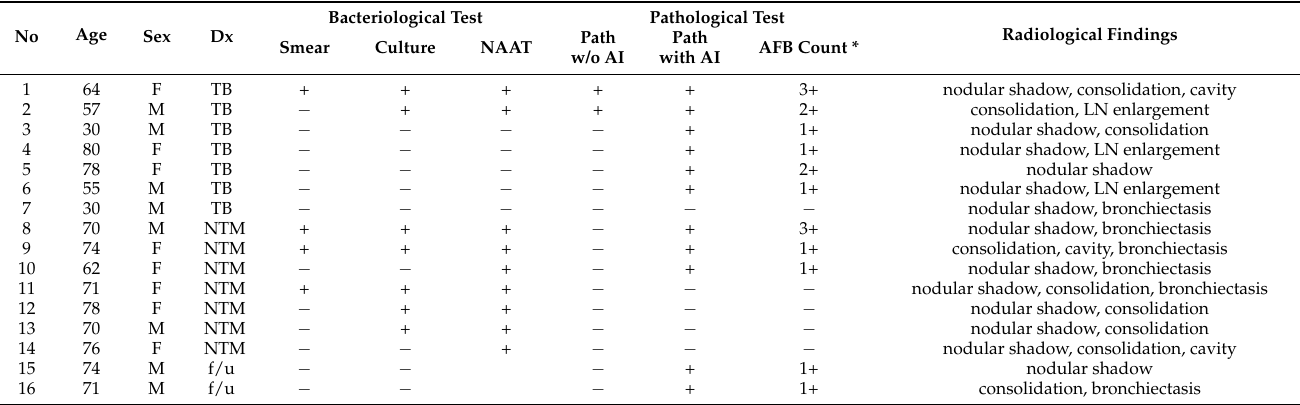
Table 4. Results of radiological, bacteriological, and pathological examinations in mycobacteriosis